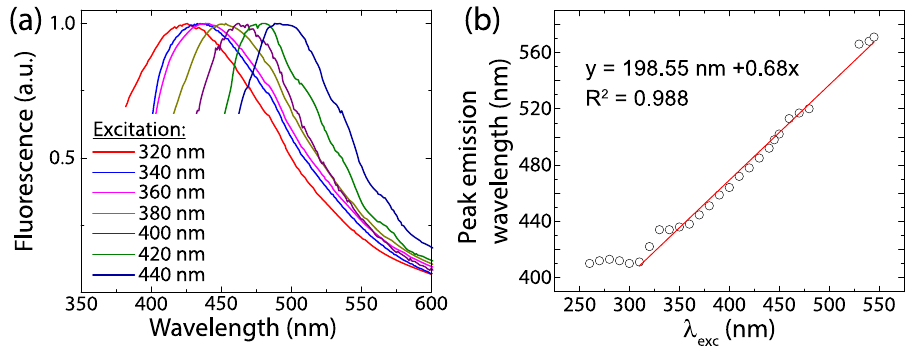
Figure 3. Illustration of the broad excitation-dependent fluorescence of our Na-uracil thin-film samples: ( a ) normalized emission spectra recorded with various excitation wavelengths, and ( b ) the essentially linear dependency of the emission wavelength on the excitation wavelength.